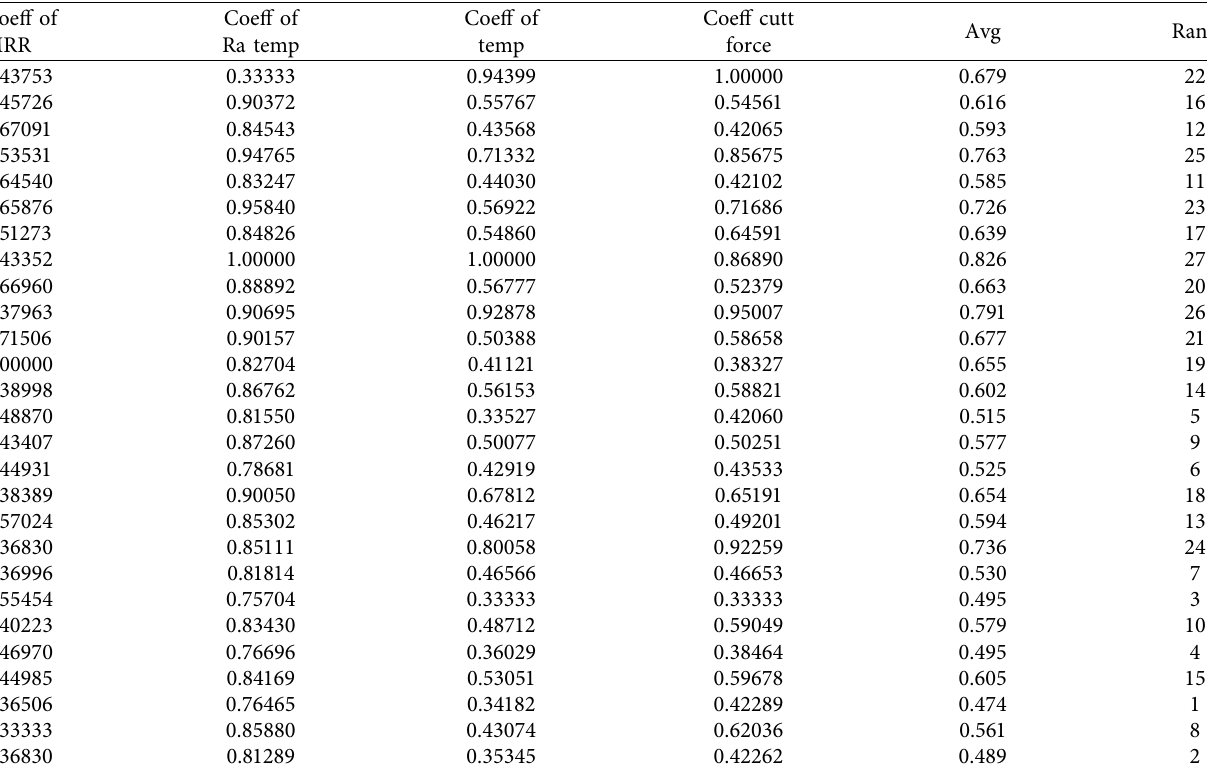
Figure 5: (a) Efect of cutting force on HNT vs. BN. (b) Efect of temperature on speed vs. feed. Table 5: Normalized value for response